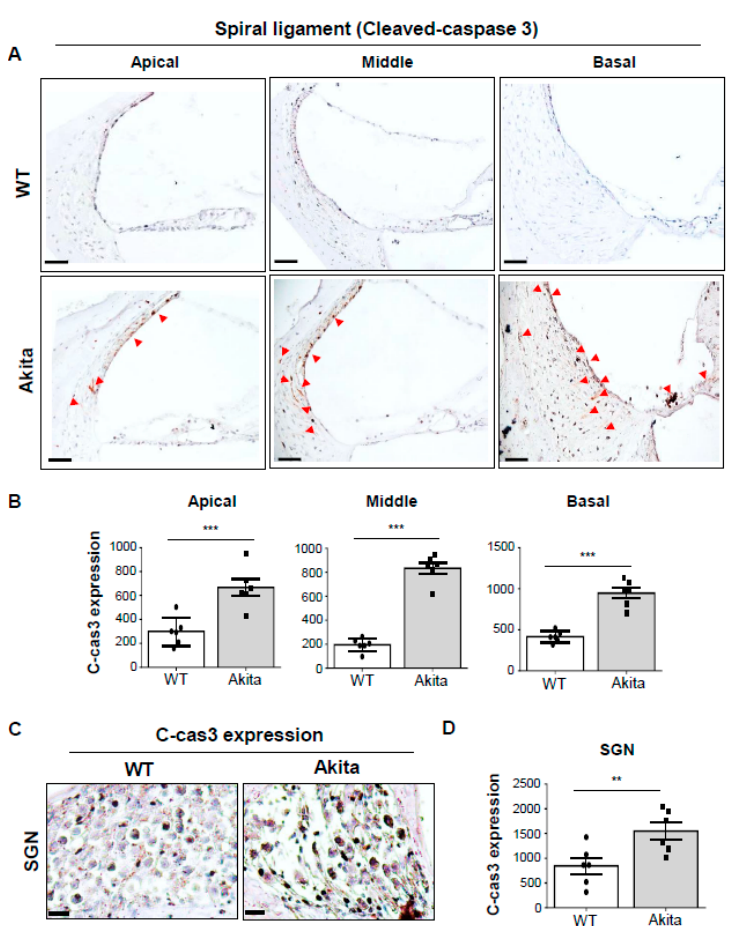
Figure 6. Quantitative analysis of activated caspase-3 immunostaining in the cochleae of WT and Akita mice. ( A ) Immunohistochemistry analysis of cleaved caspase-3 (c-cas3) from the apical, middle, and basal turns of WT and Akita mice. The expression of c-cas3 is marked by red arrowheads in the Akita group. Scale bar, 50 µ m. ( B ) The chromogenic intensity of c-cas3 quantified by Image J analysis, shown for both WT ( n = 6) and Akita mice ( n = 6). ( C ) Immunohistochemistry analysis of c-cas3 from the middle turns of the modiolus of SGNs in WT and Akita mice. Scale bar, 10 µ m. ( D ) The chromogenic intensity of c-cas3 quantified by Image J analysis, shown for both WT ( n = 6) and Akita mice ( n = 6). Results are means ± SEM. ** p < 0.01 or *** p < 0.001 by Student’s t -test.